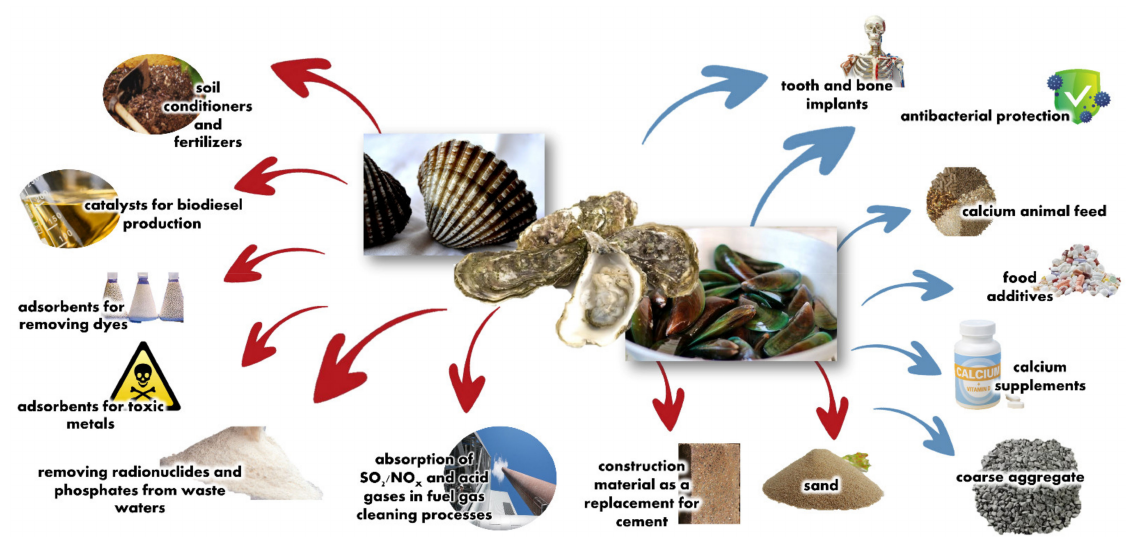
Figure 1. Potential applications of bivalve shell